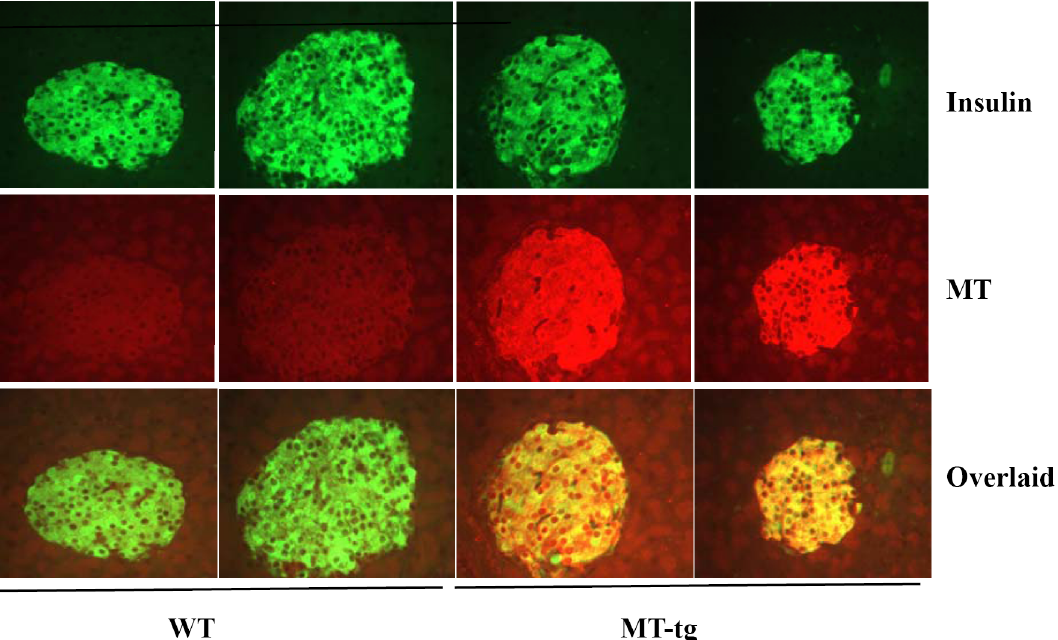
Fig 1. MT overexpression in pancreatic islets of transgenic C57BL/6J mice. MT (red) and insulin (green) immunostaining of islets of MT-tg mice and its control littermates is indicated in different colors. MT staining coincided with insulin staining is indicated by overlaid images.